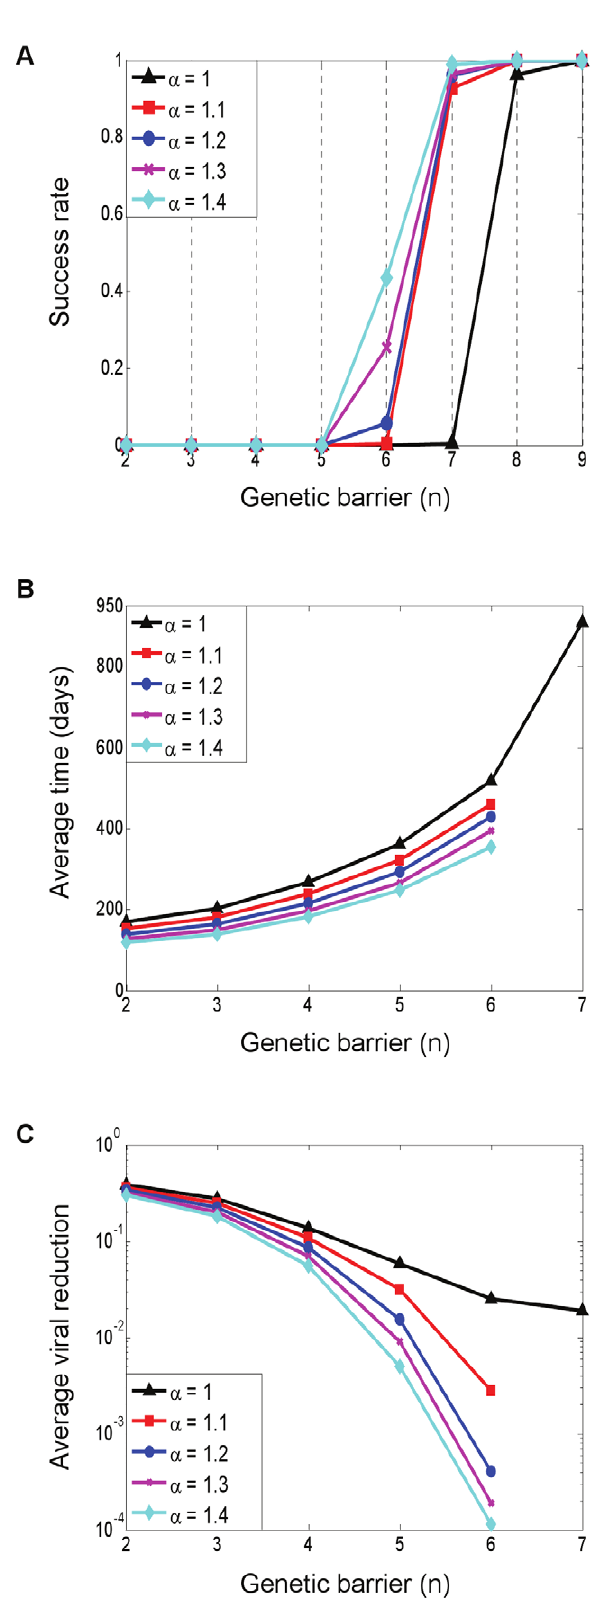
Figure 7. Effects of proliferation enhancement. Success rates (A), average fixation times (B), and average viral reductions (C) are shown as functions of the genetic barrier n (x-axis) for a range of acceleration factors ( a ). A factor a w 1 stands for a constant boost (of a { 1